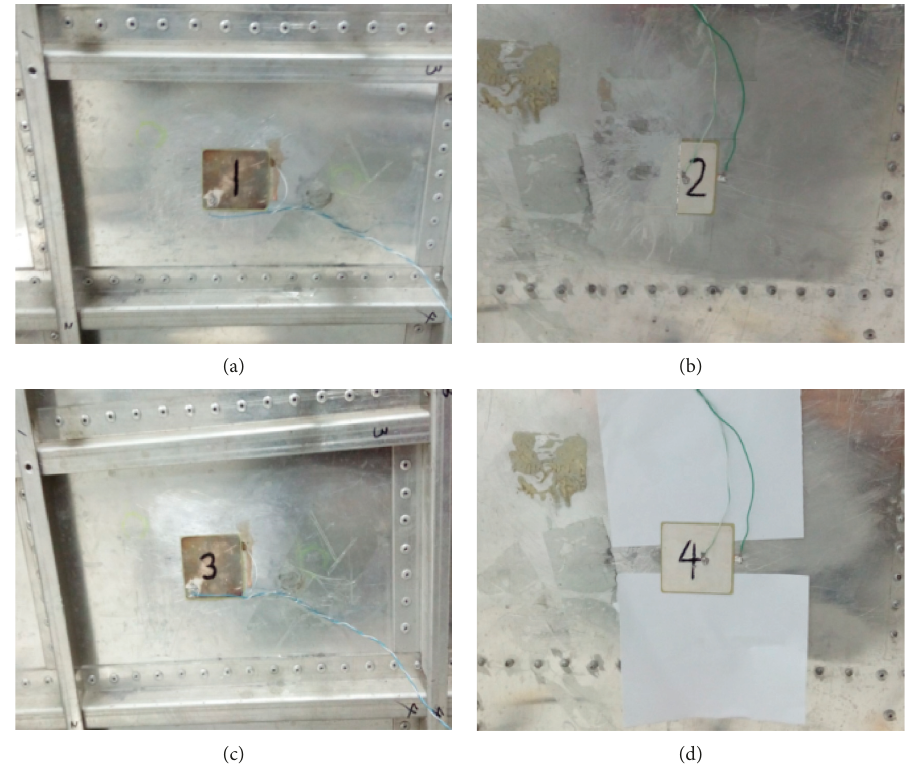
Figure 3: Piezoelectric wafer distribution: (a) normal piezoelectric patch 1 on the front; (b) broken piezoelectric patch 2 on the reverse side; (c) normal piezoelectric patch 3 on the front; (d) degummed piezoelectric patch 4 on the reverse